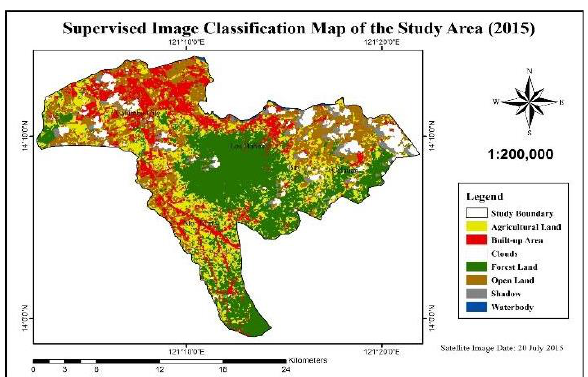
Figure 5. Supervised image classification of the study